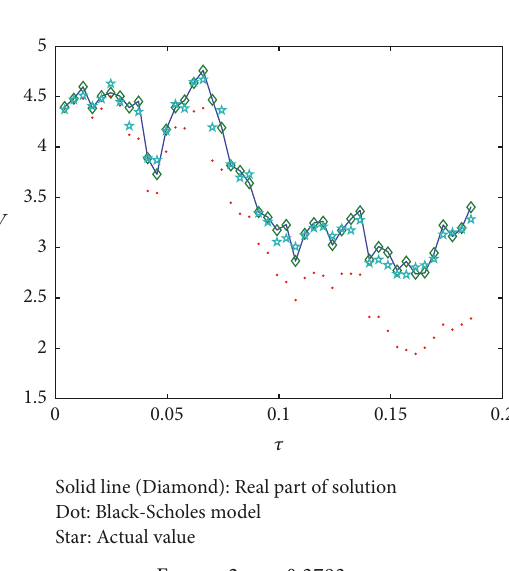
Figure 2: 𝛼 = 0.3793